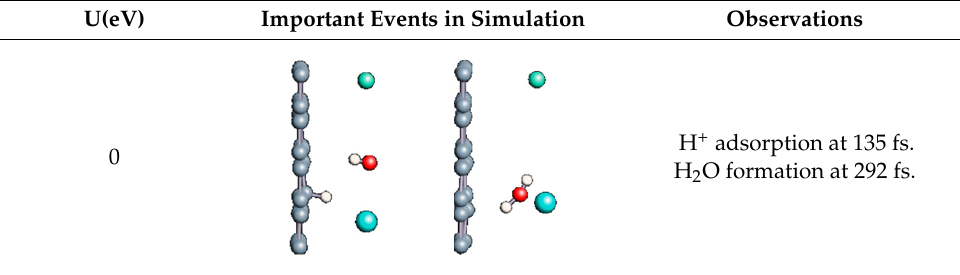
Table 2. Behavior of the dissociated water molecule near the graphene layer in the presence of salt under electric bias.